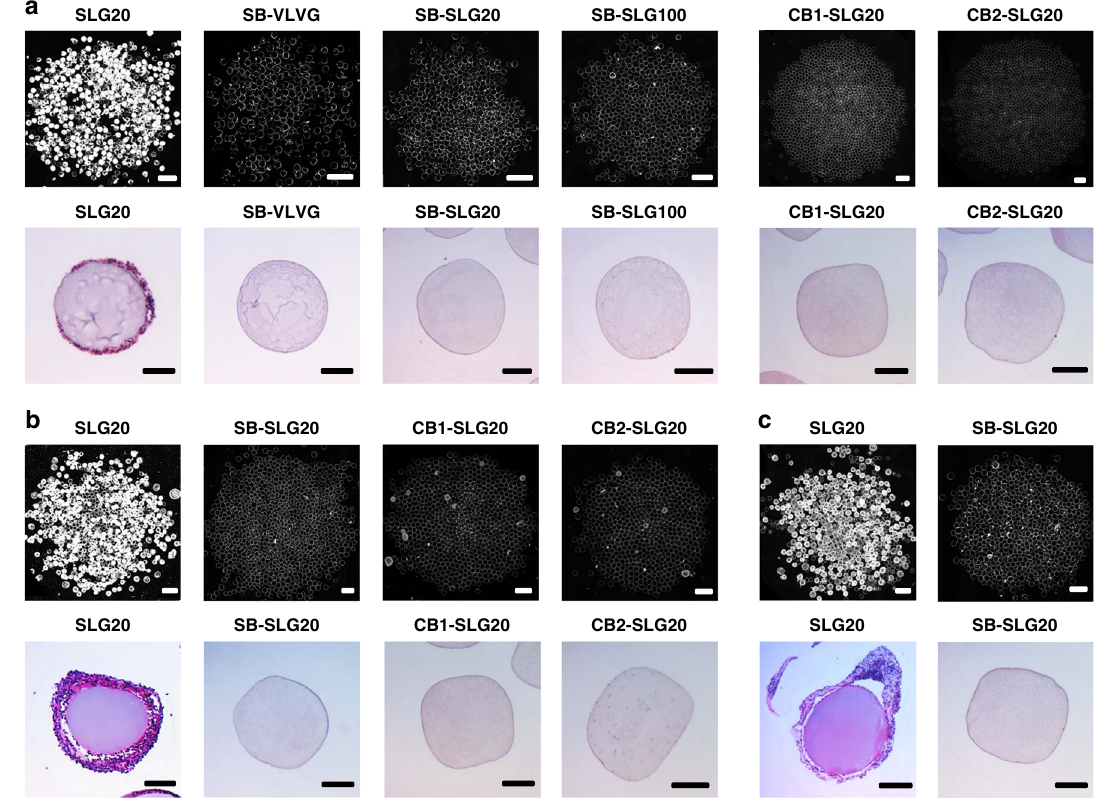
Fig. 12 for all other 9 samples from three batches with a total n = 10). The representative H&E staining of microcapsule